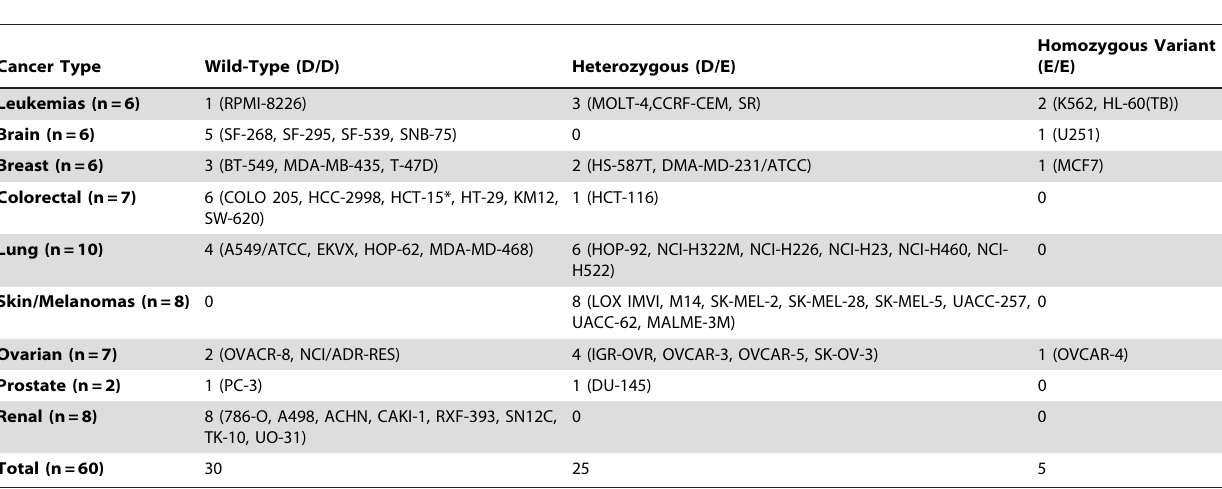
Table 2. Re-sequencing of APE1 exons in the NCI-60 cancer cell line